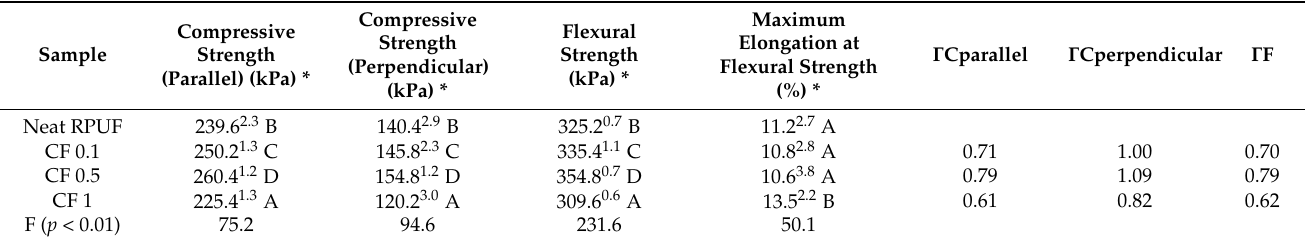
Table 3. Mechanical properties and mechanical reinforcement efficiency for compression ( Γ C) and flexural ( Γ F) tests for the studied RPUF composites.